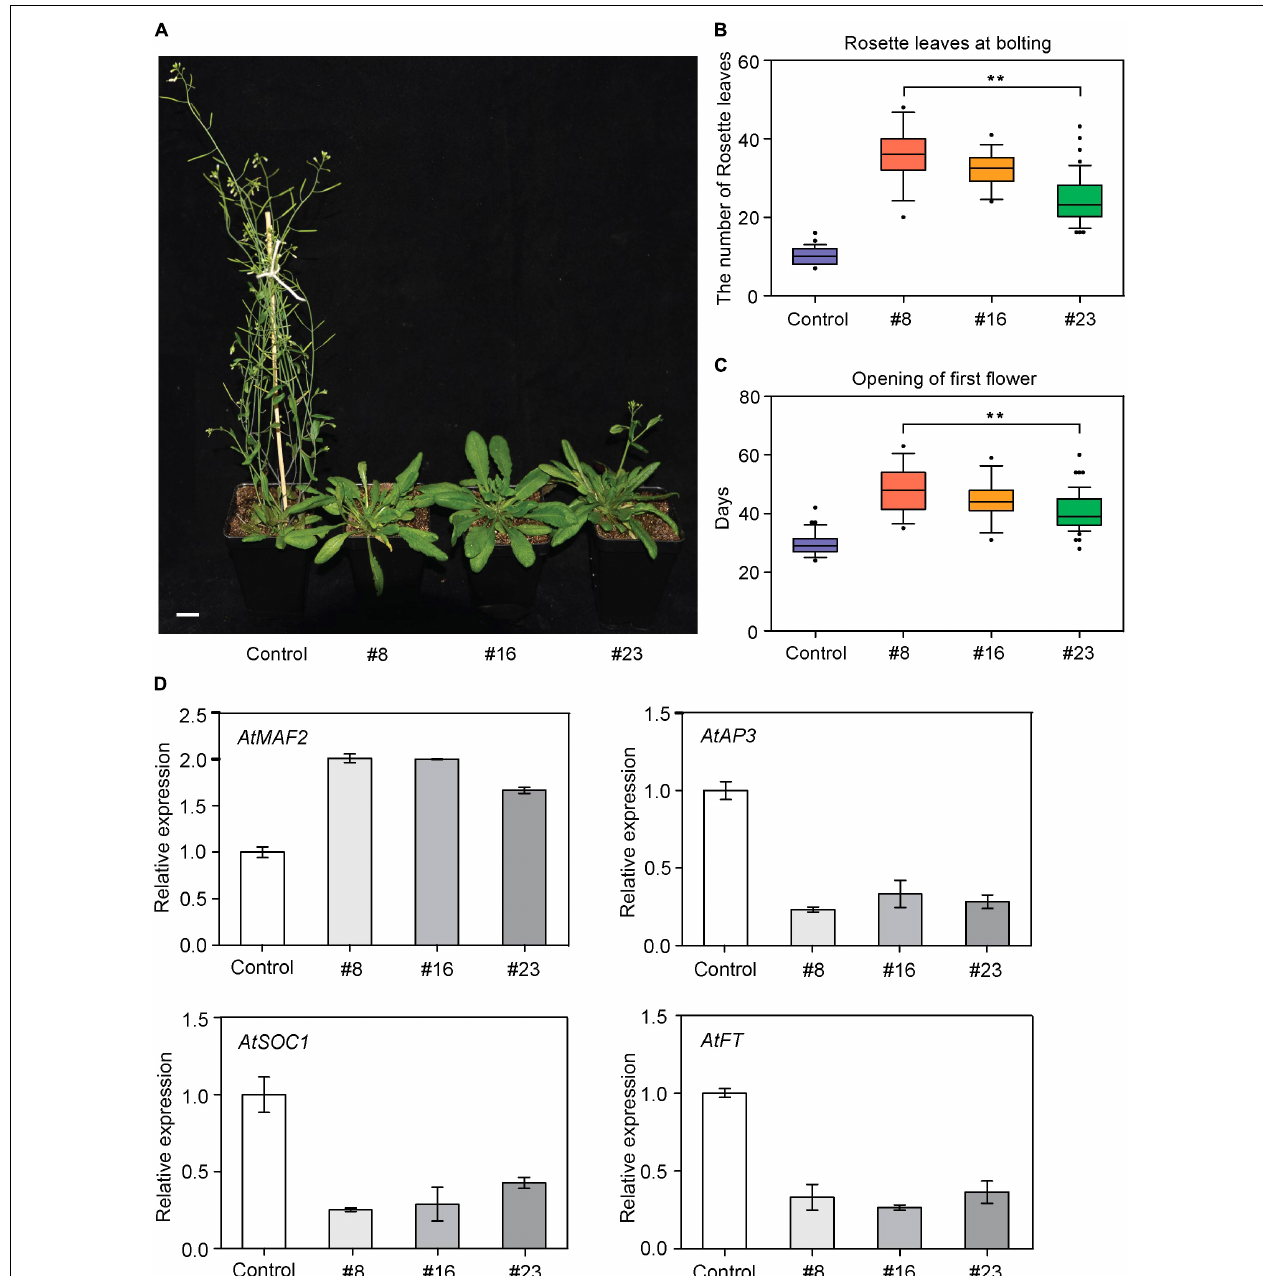
FIGURE 3 | Overexpression of BcMAF1 in Arabidopsis. (A) Late flowering phenotype of the transgenic plants overexpressed BcMAF1 . The 35S:GFP and 35S:BcMAF1-GFP#8 , #16 , and #23 plants in a chamber (LD, 16 h light/8 h dark photoperiod at 22 ◦ C/18 ◦ C). Scale bars = 1.5 cm. Rosette leaf number at bolting (B) Days of opening of first flower (C) in the 35S:GFP and 35S:BcMAF1-GFP#8 , #16 , and #23 plants. Error bars represent standard deviation of the mean number of 30 plants for each line. ∗∗ indicate significant differences from the control ( P < 0.01). (D) Expression analysis of predicted downstream genes in the 35S:GFP and 35S:BcMAF1-GFP#8 , #16 , and #23